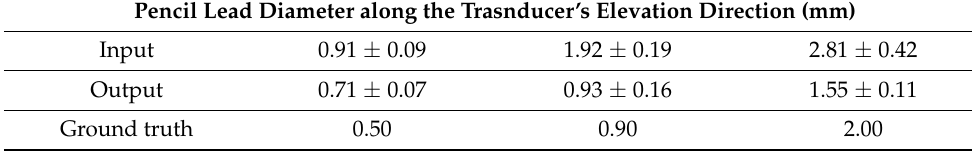
Table 4. Pencil lead diameter quantification along the transducer’s elevation